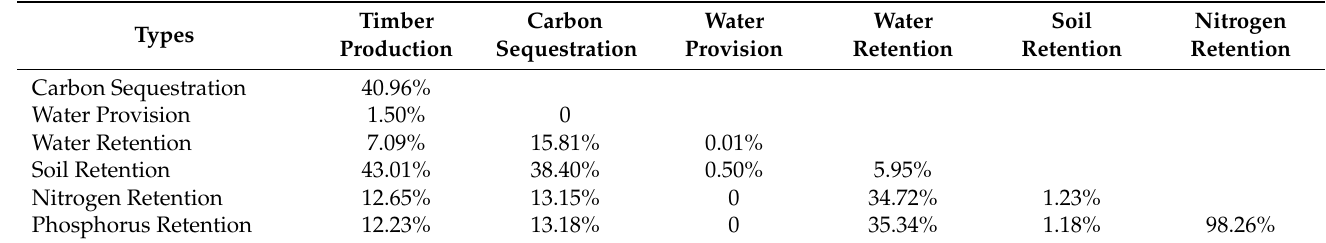
Table 2. Pair-wise overlaps between ecosystem services hotspots.